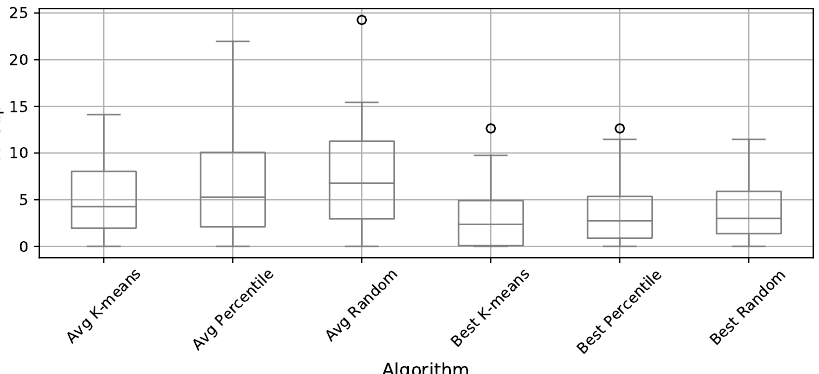
Figure 5. Average and best values box plots for 100-30 instance and sine-cosine algorithm results of Random, Percentile, and K-means algorithms.